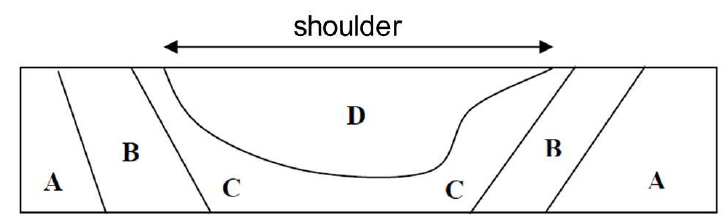
Figure 3. Typical butt joint